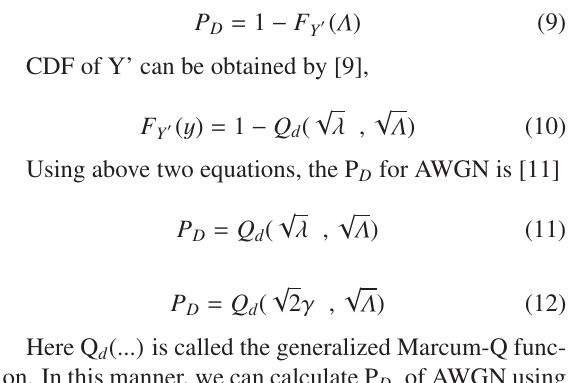
Figure 2. Functional diagram of Energy Detector